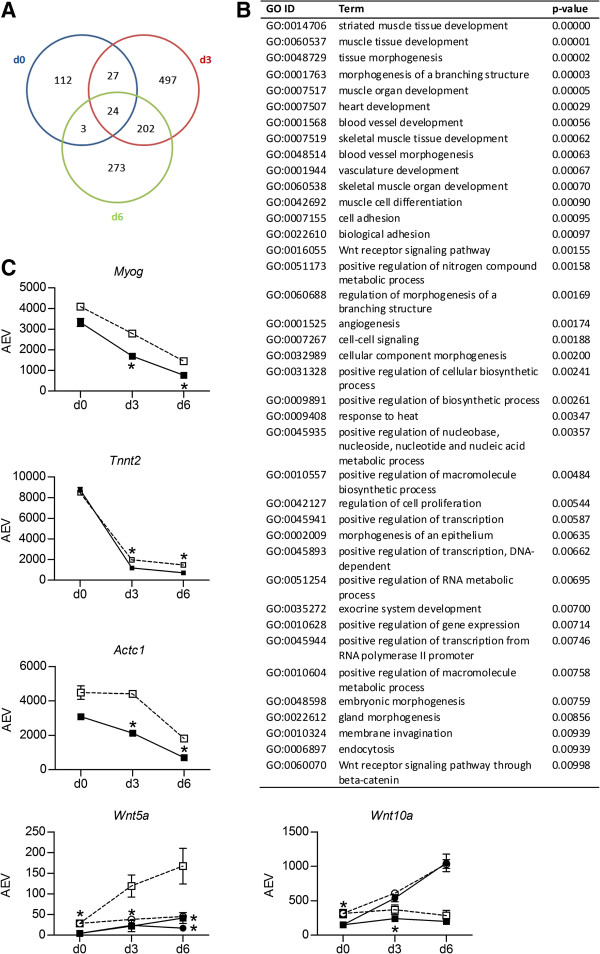
Effect of miR-378 overexpression on C2C12 bone transcription program: downregulation. A) Venn diagram representing the number of probes on the microarray that are significantly (as defined in Methods) lower expressed in C2C12-pMirn378 cells than in control C2C12-pMirn0 cells at each time point during differentiation in the presence of 300 ng/ml BMP2. B) Enriched (p < 0.01) GO terms (in biological processes category) within the set of probes that are significantly lower expressed in C2C12-pMirn378 versus C2C12-pMirn0 cells at at least two consecutive time points during differentiation in the presence of 300 ng/ml BMP2. C) Microarray profiles of representative genes that are expressed at significantly lower levels in C2C12-pMirn378 cells than in C2C12-pMirn0 cells at at least two consecutive time points during differentiation in the presence of BMP2 (light bullets: C2C12-pMirn0, dark bullets: C2C12-pMirn378, squares: treatment with BMP2, circles: treatment without BMP2); Myog, troponin T2, cardiac (Tnnt2; 1418726_a_at), actin alpha cardiac muscle 1 (Actc1; 1415927_at), wingless-related MMTV integration site 5a (Wnt5a; 1436791_at) and 10a (Wnt10a; 1460657_at). For Myog, Tnnt2 and Actc1, expression levels are only shown for cells treated with BMP2. Mean expression values +/− SD from triplicate microarray experiments are shown for all data points. When the error bar is not visible, the SD falls within the printed data point. All SD values are, however, listed in Additional file 2. AEV = average expression value; *significantly different expression in C2C12-pMirn378 compared to control C2C12-pMirn0 at the same time point and treatment (see Methods for definition).